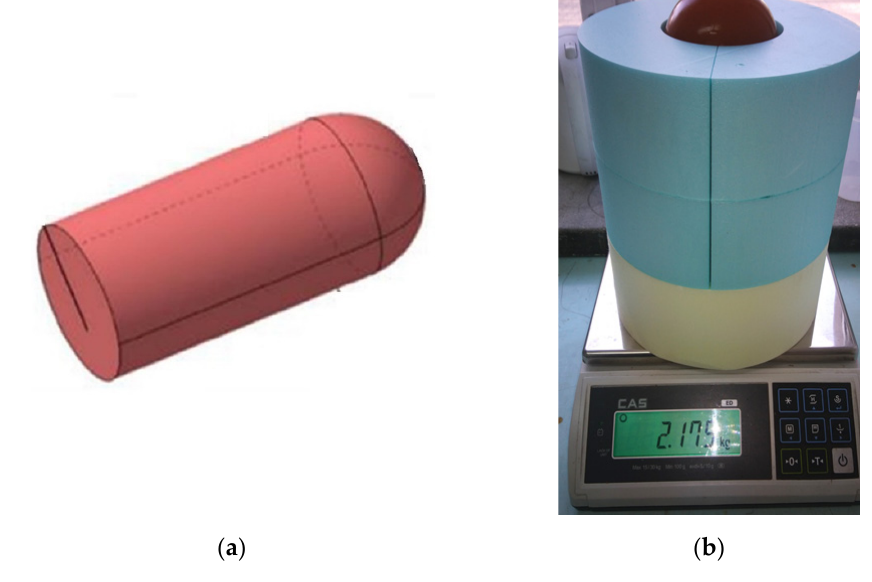
Figure 7. Gelatin projectile: ( a ) shape; ( b ) inside sabot.